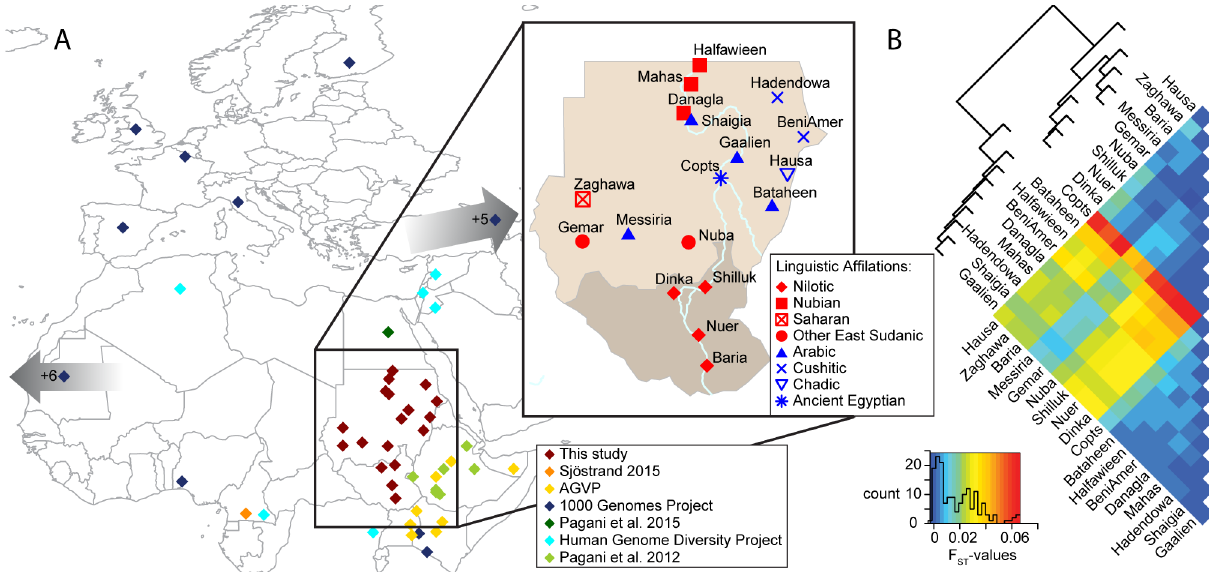
Fig 1. Overviewof populations investigated in this study. (A) Partial map of Africa and Europe showingthe populationsinvestigatedin this study. Gumuz and S.Sudanesewere not includedin the figure as the geographicsamplingcoordinates were unclear. Coordinates were approximated for the 1000Genome, HGDP, Egyptian, Nzime and Somalipopulations.This study includeseleven populations from the 1000Genome Project that have been sampledfrom areas outside of the map range, indicatedby the arrows. Colors of the symbols indicate project affiliations. A zoom on Sudan and South Sudan shows the geographicmidpoint of the populationssampledin this study. The colors of the symbols indicatelinguisticaffiliation, Nilo-Saharan speakersare shown in red and Afro-Asiatic speakersin blue. The Nuba, shown in red, also speak Kordofanian, a Niger-Congo language.(B) Pairwise F ST of the Sudaneseand South Sudanese populations. The key shows the F ST -valueson the x-axis and the y-axis displaysthe amount of observedinstancesin a histogram. A UPGMA tree is shown that was calculatedusing the F ST